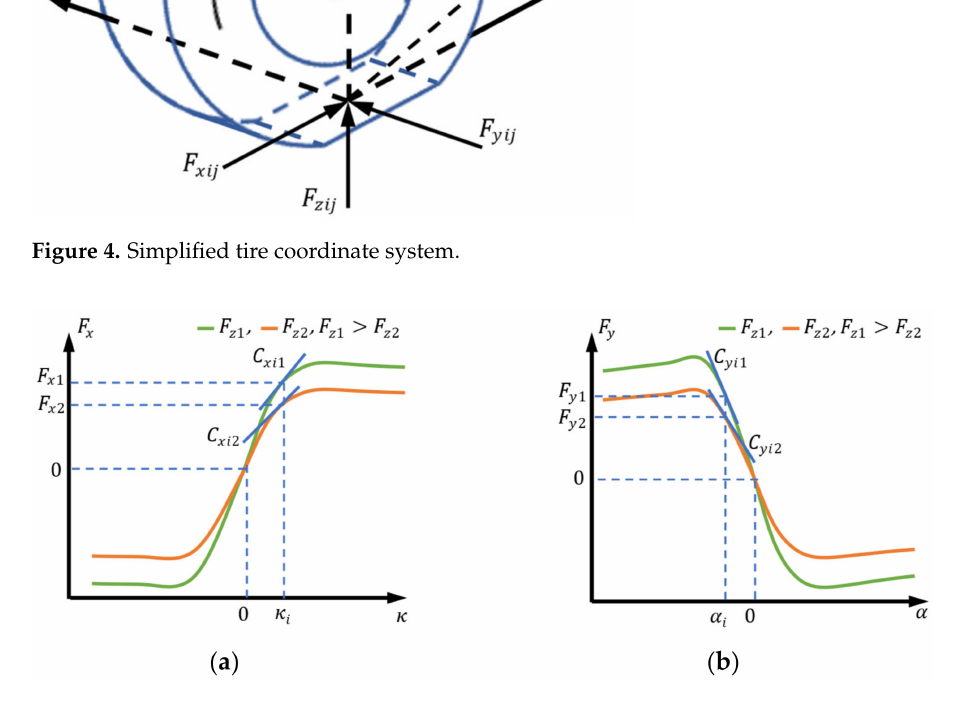
Figure 5. The representation of UniTire: ( a ) the longitudinal tire force in which κ i is the TYDEX longitudinal slip ratio and C xi 1 and C xi 2 are slip stiffnesses under different vertical forces F z 1 and F z 2 ; ( b ) the lateral tire force in which C yi 1 and C yi 2 cornering stiffnesses under different vertical forces F z 1 and F z 2